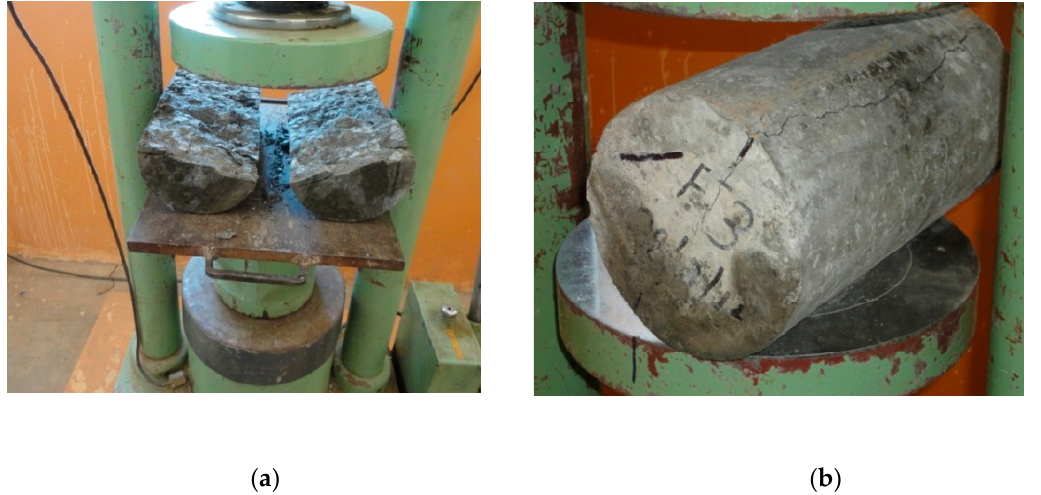
Figure 4. Specimens after split-tensile strength testing . ( a ) Plain concrete specimen at failure. ( b ) Concrete specimen with fibres (F1) at failure.